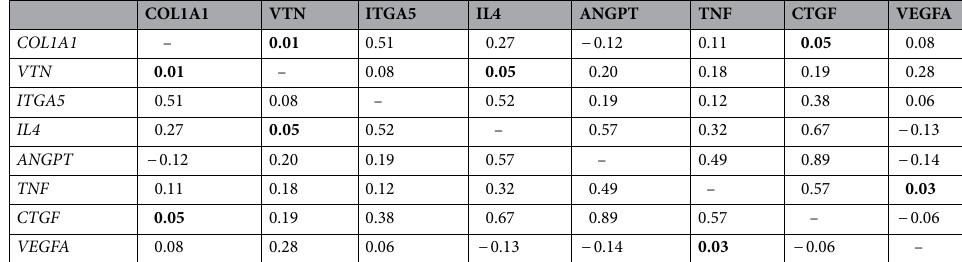
Table 3. Correlation between relative gene expression of COL1A1, VTN, ITGA5, IL-4, TNF, ANGPT, VEGFA, and CTGF in the healing group. The table shows the correlation coefficient (r) value between each gene pair, where gene pairs exhibiting statistically significant ( p < 0.05) correlation are bold.